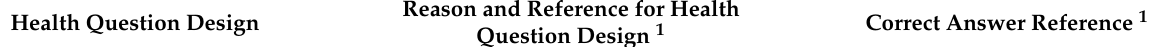
Table 1. Example of the design concept of health-related questions of concern to undergraduate students. Reason and Reference for Health Question Design